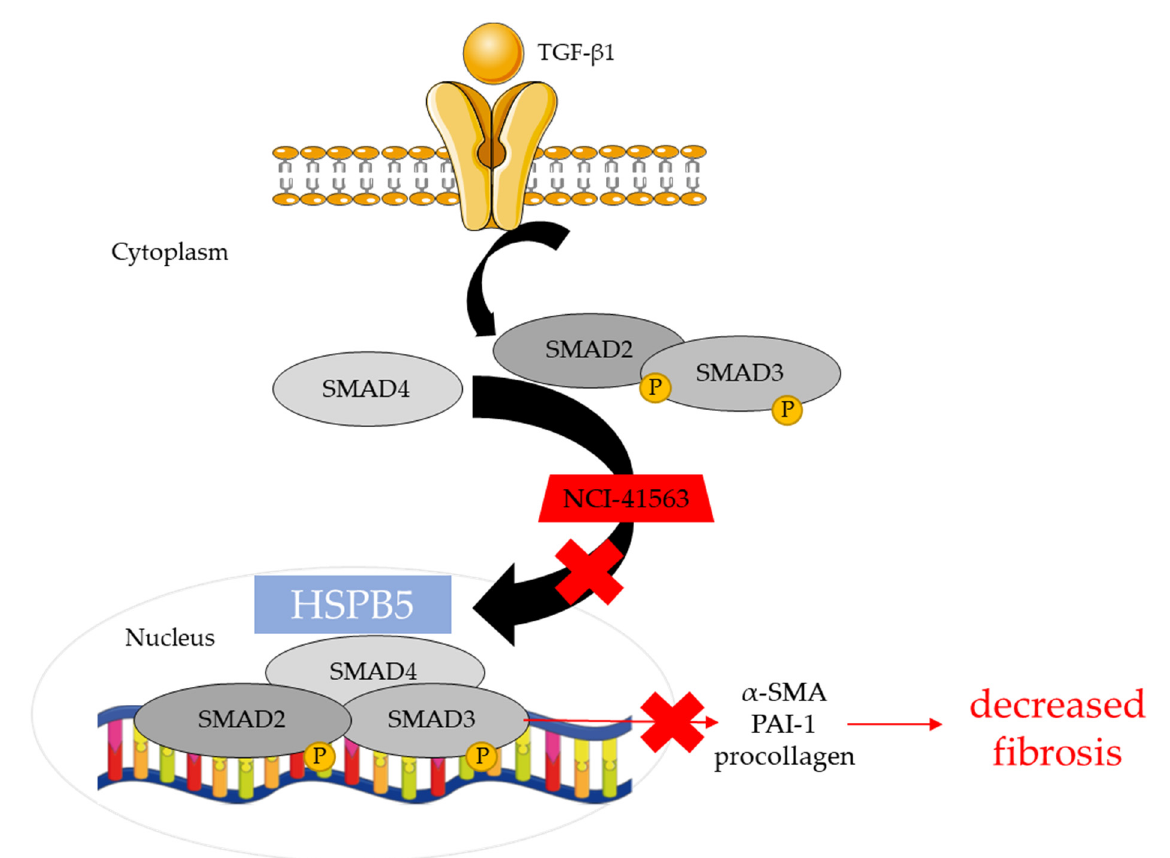
Figure 5. Proposed mechanical pathway involved in inhibitory effects of NCI-41356. NCI-41356 inhibits the interaction between HSPB5 and SMAD4, thus hampering the translocation of the SMAD4/pSMAD2/pSMAD3 complex into the nu- cleus. As a consequence, NCI-41356 limits the synthesis of collagen, pro-fibrotic markers and subsequent fibrosis.